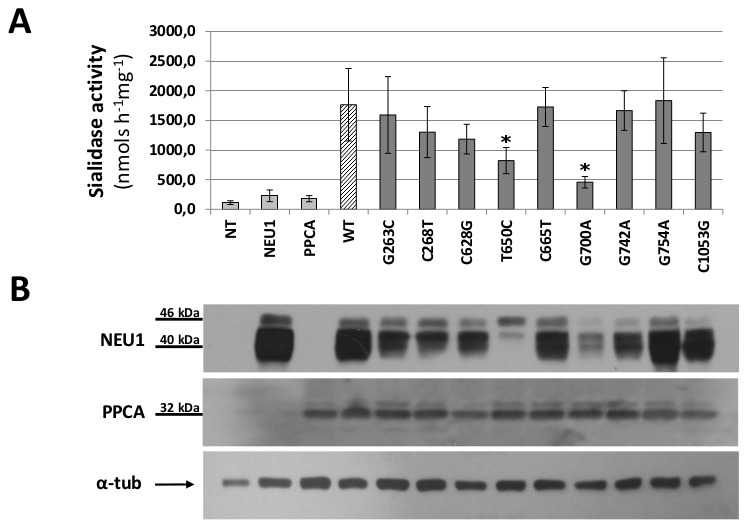
Sialidase activity assay and immunoblotting analysis.(A) Sialidase specific activity calculated for COS7 cells non transfected (NT), transfected with NEU1 wt alone (NEU1), PPCA alone (PPCA), NEU1 wt and PPCA (WT) and NEU1 mutants and PPCA. V217A and D234N mutant proteins resulted in a significant reduction in sialidase activity (p<0.05, marked with *). (B) Immunoblotting for PPCA and NEU1 proteins in each sample. NEU1 showed the expected signals between 40 and 46 kDa, corresponding to different glycosylation states; PPCA showed the expected signal at 32 kDa, corresponding to the heavy peptide of the active form of the protein. α-tub was used for protein loading normalization. The image is representative of 3 replicate experiments.